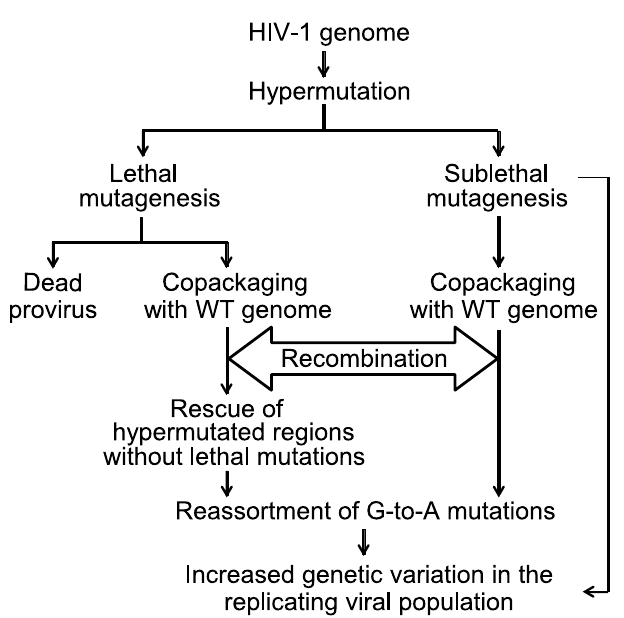
Fig 5. Flow chart of potential contribution of hypermutation and recombination to HIV-1 genetic